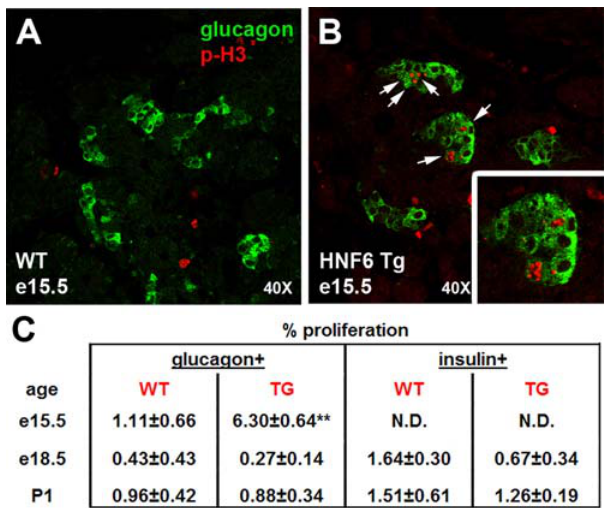
Figure 6. Increased proliferation of glucagon + cells in Hnf6 Tg pancreata. Proliferation rates in WT ( A ) versus Hnf6 Tg ( B ) pancreata were determined by co-immunohistochemistry for phosphorylated histone H3 (p-H3, red) and either glucagon (green) or insulin (data not shown). (C) Number of cells that co-expressed p-H3 and either glucagon or insulin are expressed as a percentage of the total hormone + cells counted at e15.5, e18.5, and P1; ** p =0.004.